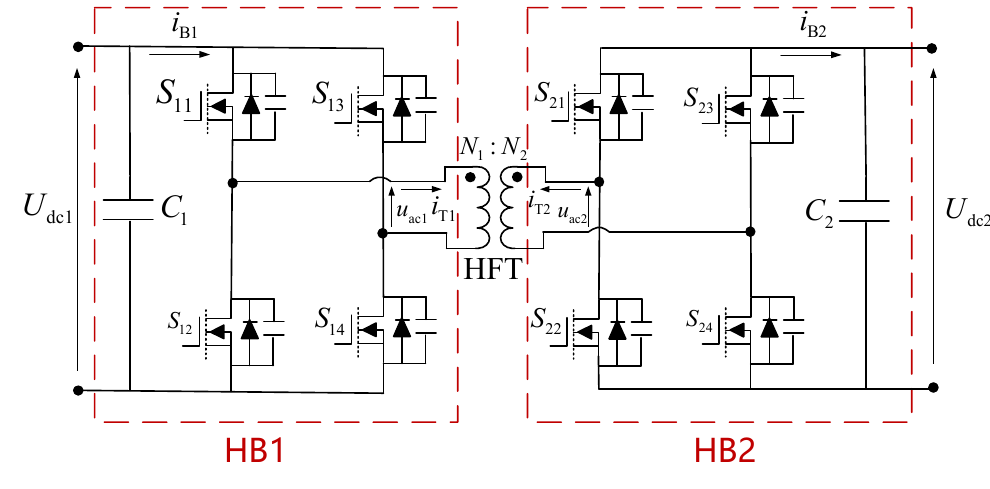
Figure 1. Topology of high-frequency isolated energy storage converter. The DAB module is the primary function module of the topology, which realizes the DC bidirectional converter and isolation, as shown in Figure 2. Each DAB module consists of two sets of H-bridges, an HFT (high-frequency transformer), and corresponding capacitor components C 1 and C 2 [21]. The leakage inductance of HFT is the key to realizing the ZVS (Zero Voltage Switch) under phase-shifting control [25,26]. In Figure 2, U dc1 and U dc2 are DC voltages at both ends of the converter, U ac1 and U ac2 are the HFT primary and secondary AC voltages, i T1 and i T2 are the HFT primary and secondary AC currents, n = N 1 / N 2 represents the transformation ratio of HFT, and S 11 –S 24 are power electronic devices.